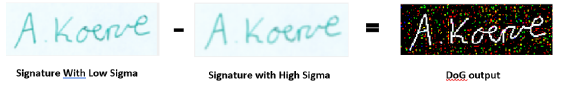
Figure 3. DoG Output